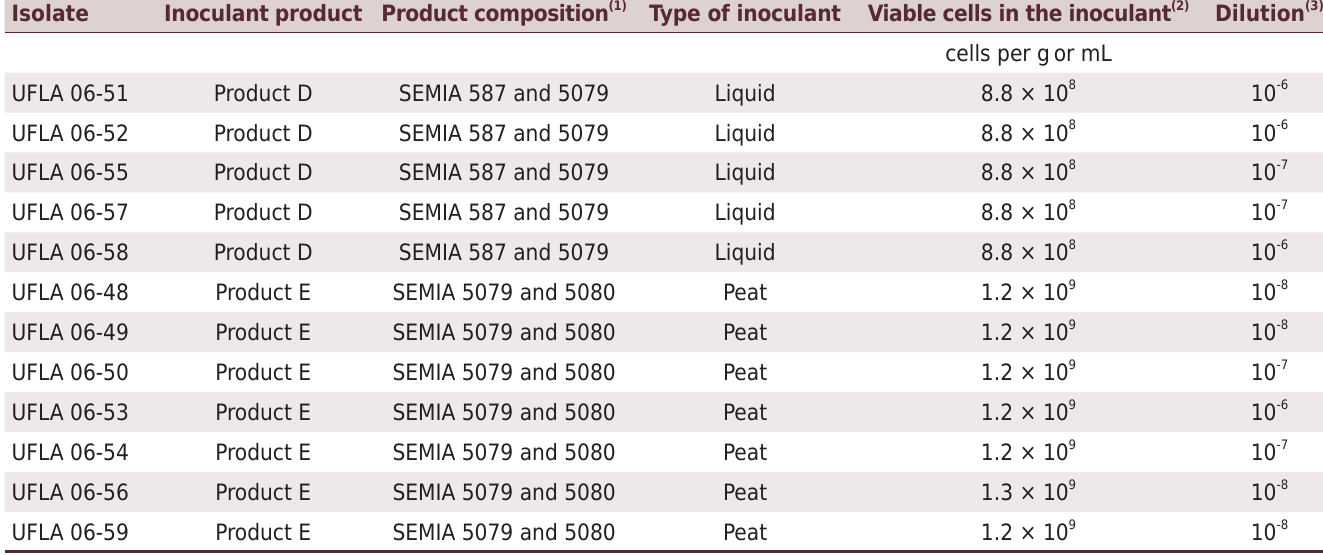
(1) Inoculant strains indicated in the product formulation. (2) Number of viable bacterial cells in the product. (3) Dilution of the inoculant sample in which the isolate was